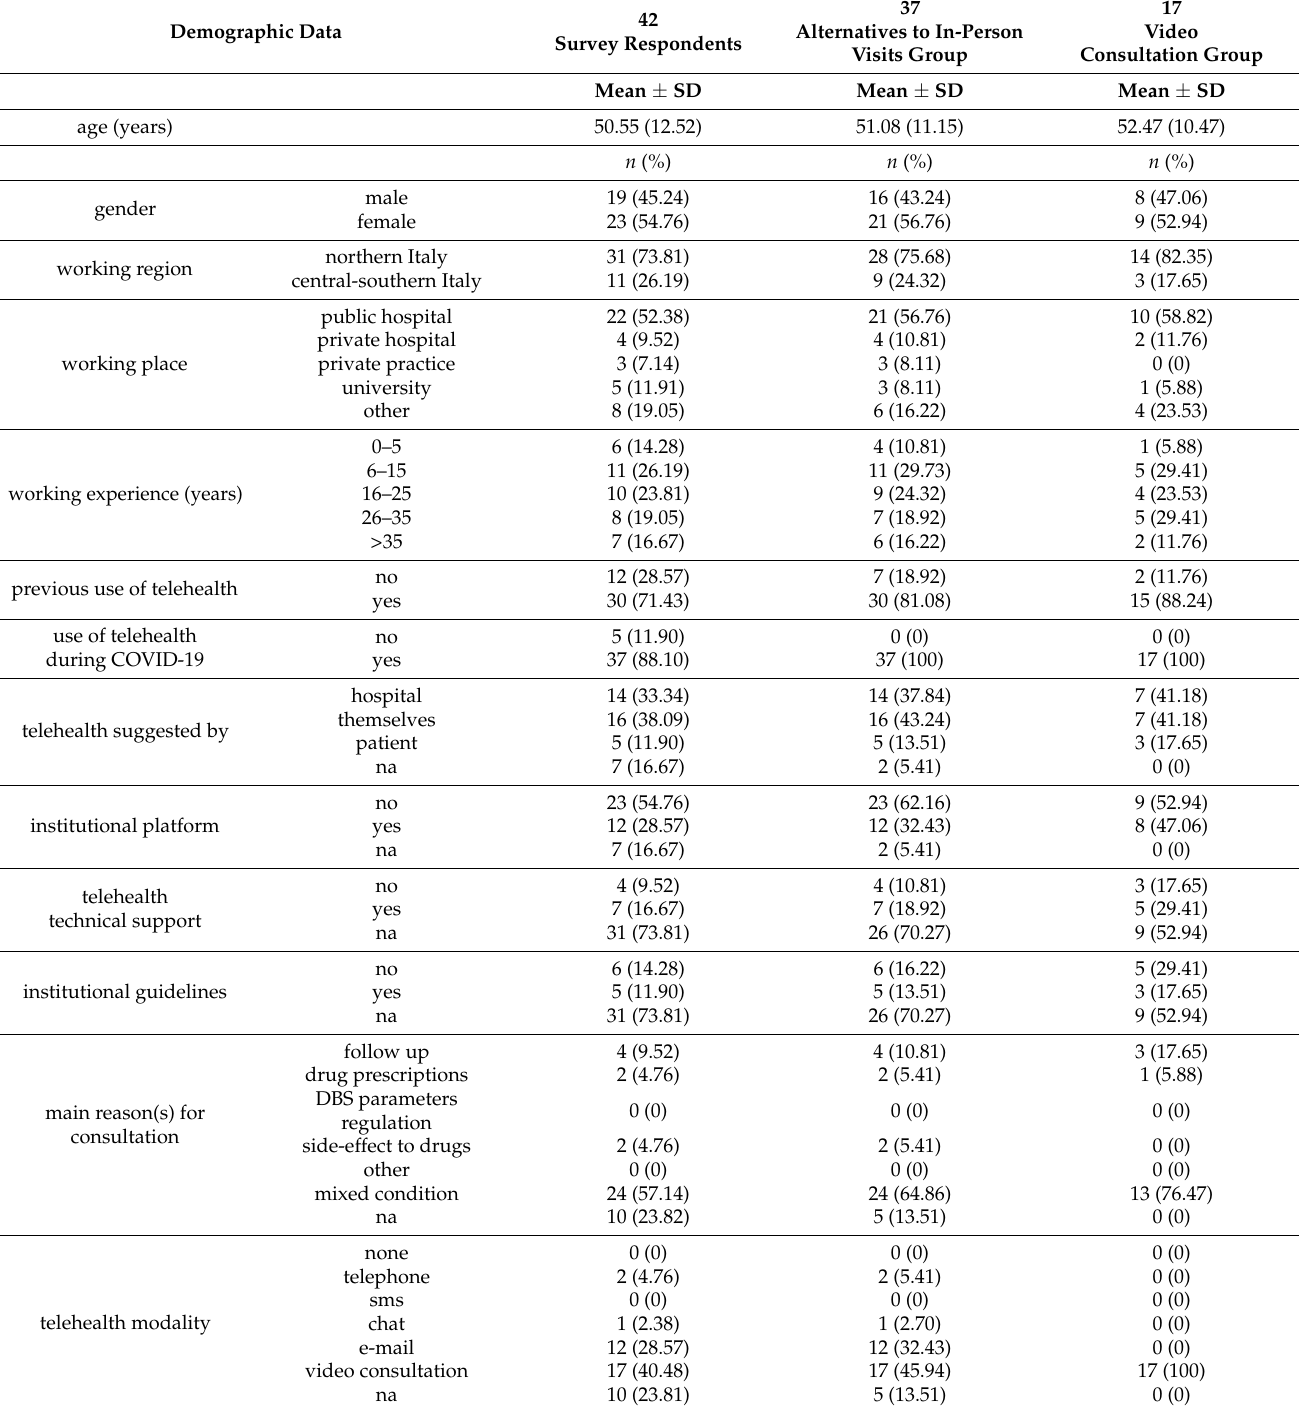
Table 5. Demographic data of neurologist and telehealth